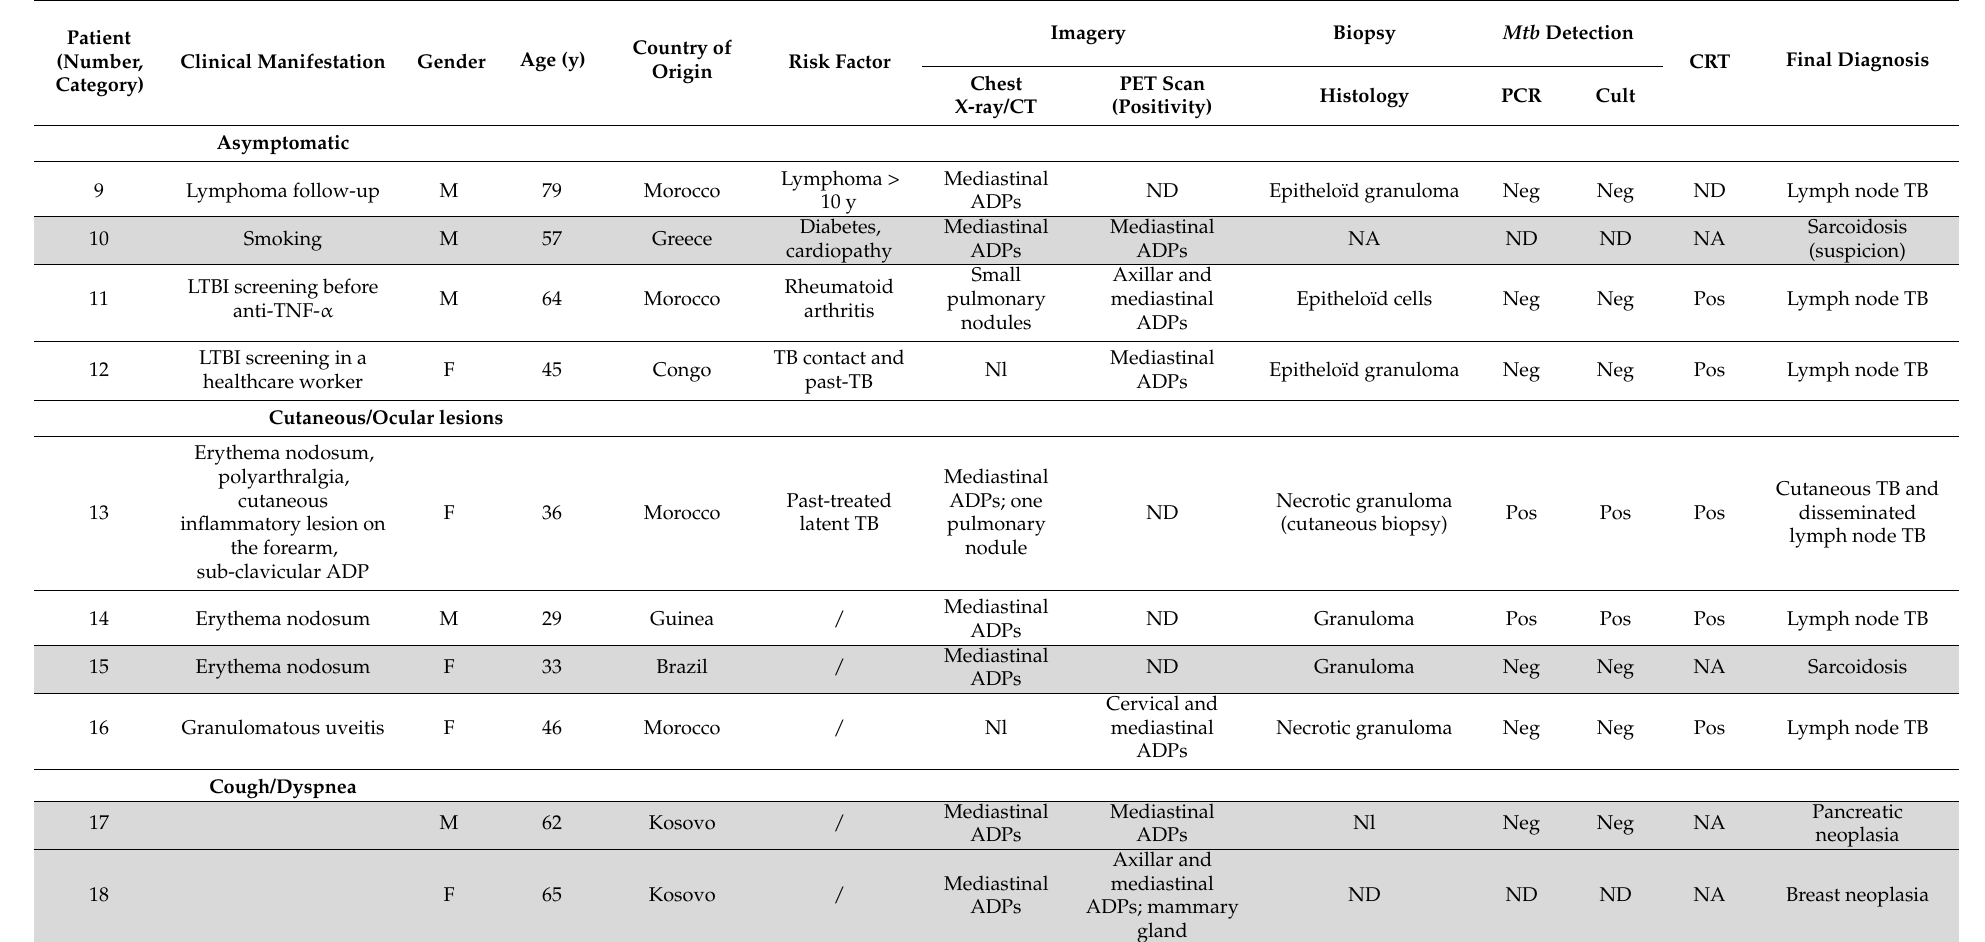
Table 2. Characteristics of patients included in group 2 with mediastinal